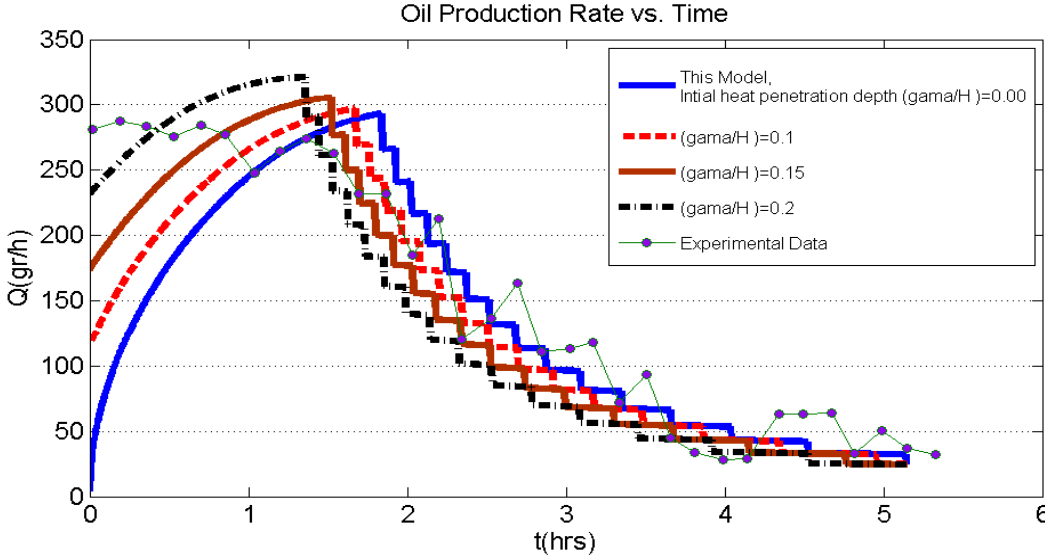
Figure 10. Comparison of the results from the new model with various heat penetration depth estimates against the experimental data.